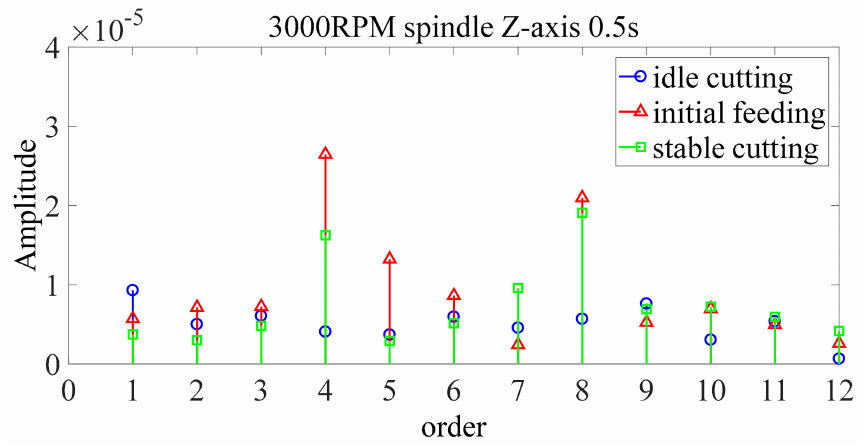
Figure 9. Order spectrum at Z axis at 3000 rpm; removing features not related to rotation speed.